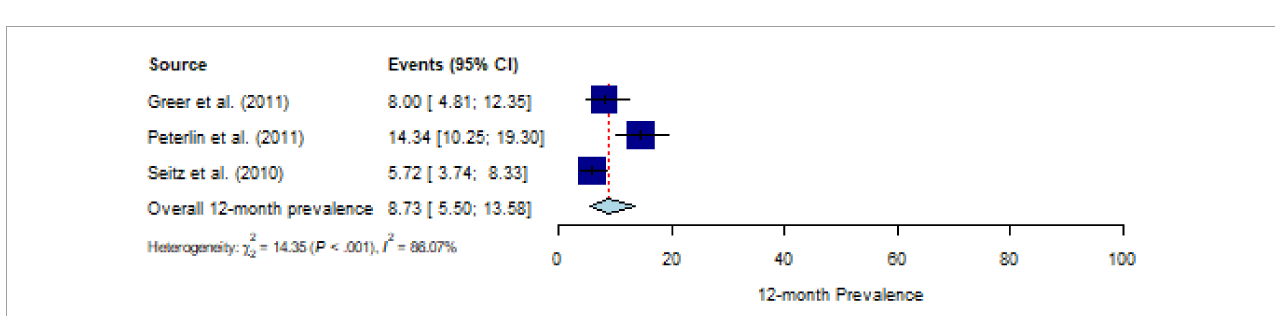
FIGURE4 Forest plot of 12-month prevalence of post-traumatic stress disorder (PTSD) in people with chronic somatic diseases (CD).